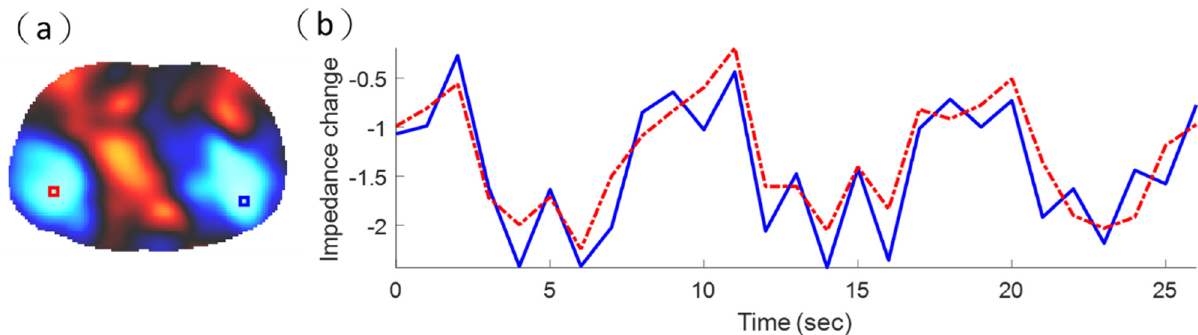
Figure 13. The reconstructed electrical impedance tomography (EIT) image obtained using the wearable textile-electrode belt. ( a ) EIT imaging of lung ventilation. ( b ) Two-pixel waveforms in the left lung (red) and right lung (blue).